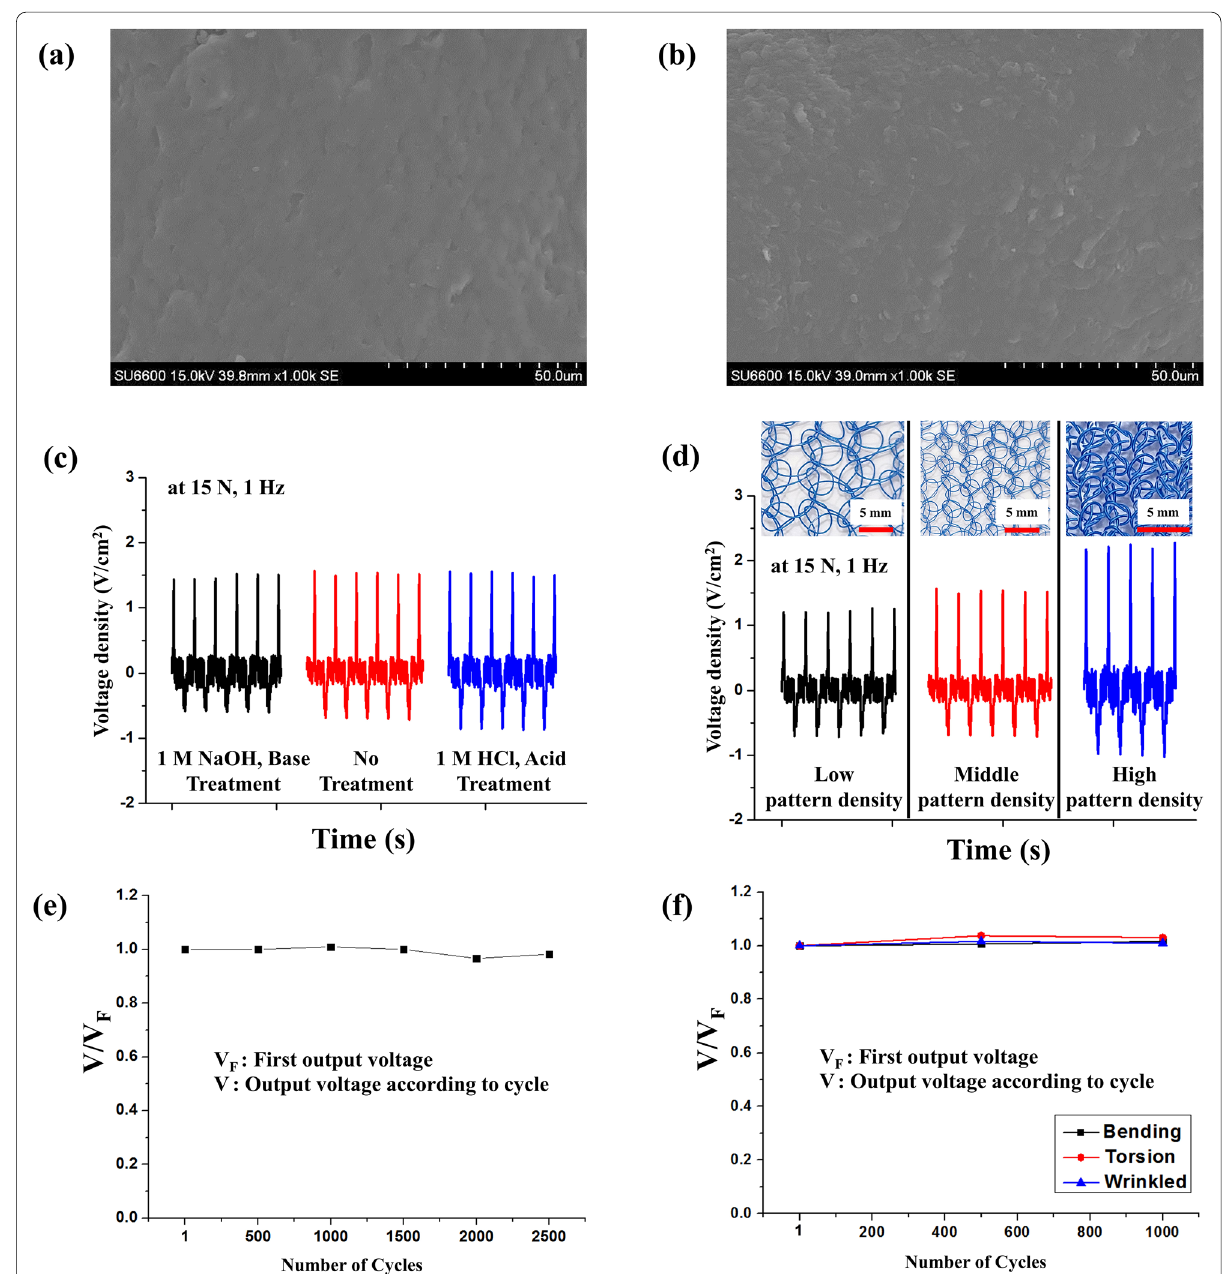
Fig. 3 SEM image of T‑TENG after ( a ) Acid treatment and ( b ) Base treatment. c Output voltage density of T‑TENG using 100 MΩ depending on treatment. d Output voltage density of T‑TENG using 100 MΩ depending on pattern density. e Relative change of output voltage of T‑TENG by repetition of contact‑separation. f Relative change of output voltage of T‑TENG according to durability